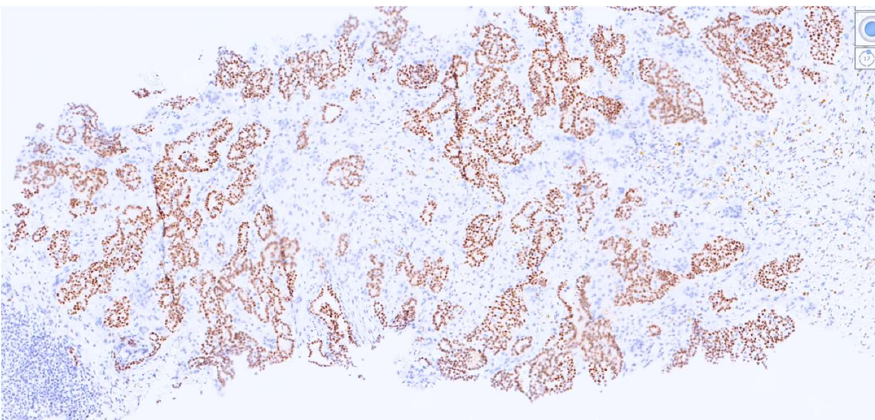
Figure 7. Immunoreactivity for progesterone receptor in almost all neoplastic cells of the presurgical biopsy (100×).